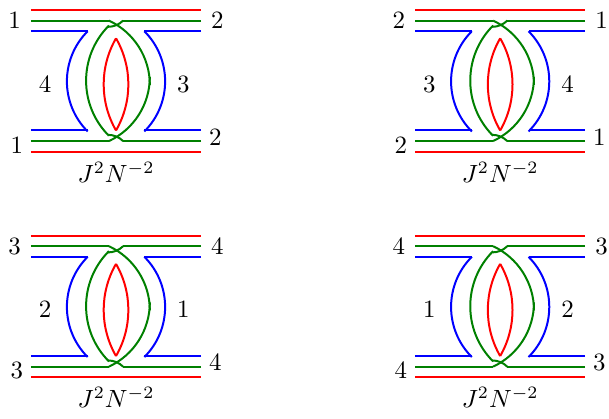
Figure 22. Dipoles in the GW